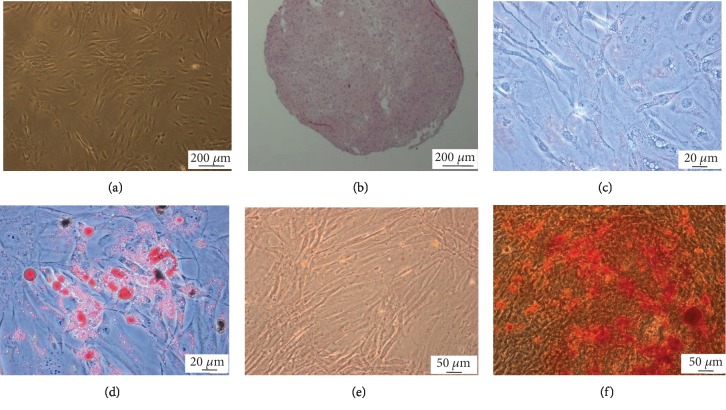
Human ASC morphology and differentiation potential. Light microscopy: (a) undifferentiated hASCs; (b) chondrogenic differentiation, HE staining of chondropellet; (c, d) adipogenic differentiation, Oil Red O staining (lipid droplets are red) of hASCs cultured in standard (c) and adipogenic (d) medium; (e, f) osteogenic differentiation, Alizarin Red staining (calcium deposits are red) of hASCs cultured in standard (e) and osteogenic (f) medium. Scale bars: 200 μm (a, b), 20 μm (c, d), and 50 μm (e, f).